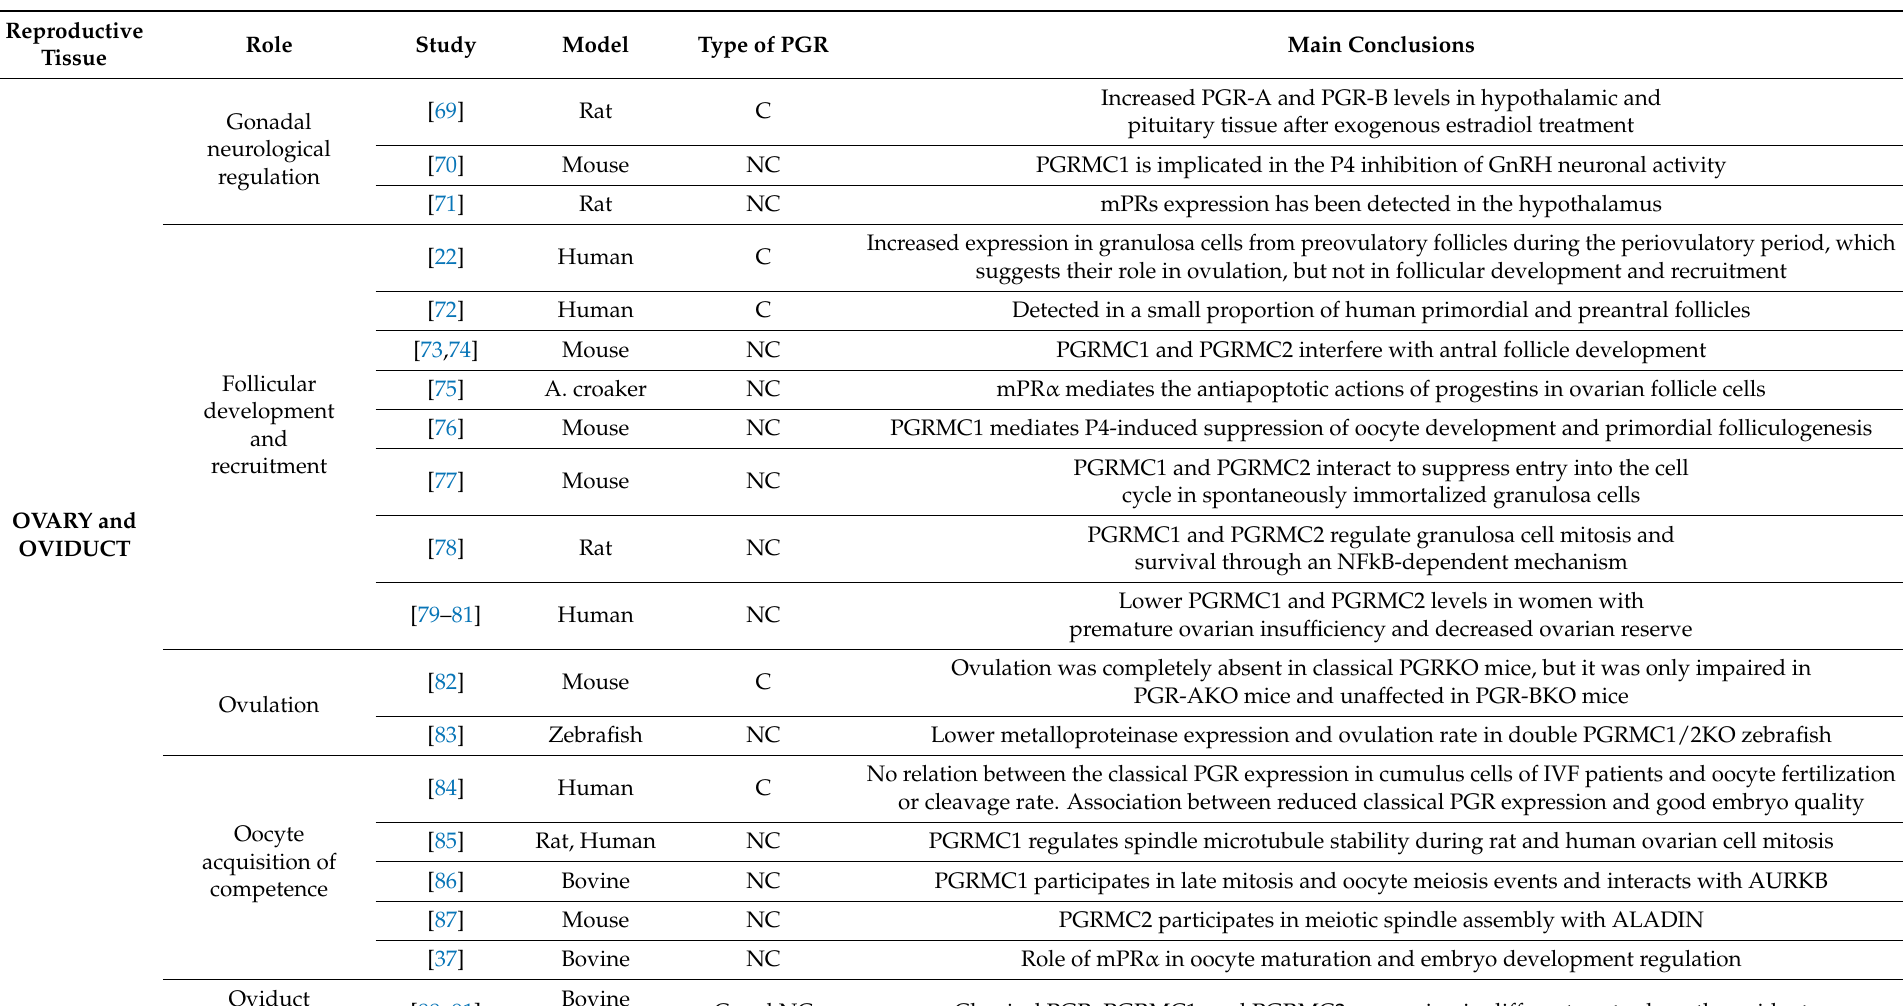
Table 1. List of the main human and animal studies to have assessed PGR functions in reproductive tissues: ovary and oviduct, and uterus. C = classical. NC = non classical. Reproductive